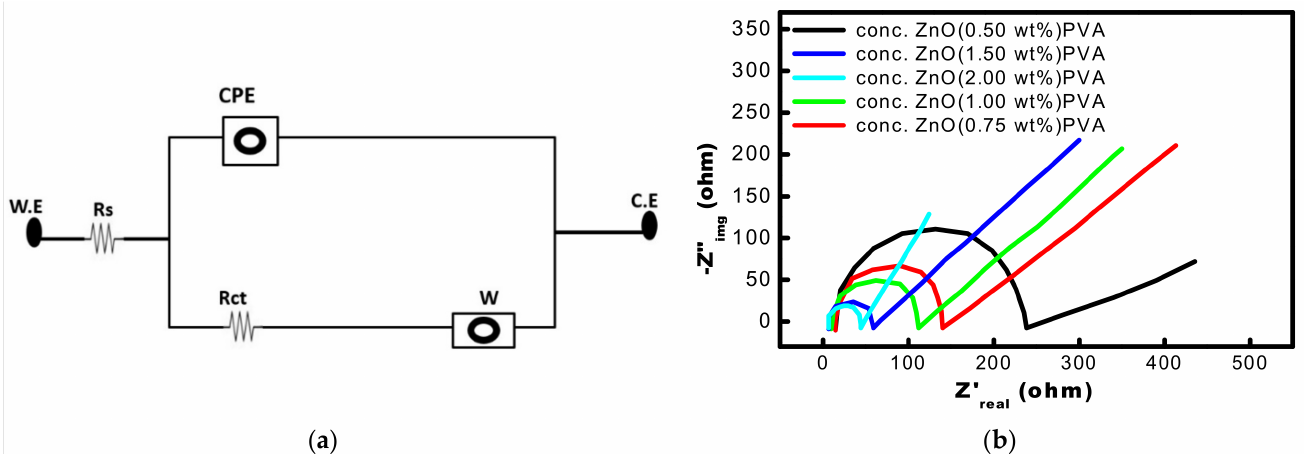
Figure 10. ( a ) The analogous circuit for a single-chambered MFC simulates different resistances. ( b ) Nyquist plot MFCs loaded with varying concentrations of Li-ZnO (0.50, 0.75, 1.00, 1.5, and 2.0 wt%) recorded at a frequency range of 1 MHz to 100 kHz (WE = working electrode, Rs = solution resistance, CPE = constant phase element, Rct = Charge transfer resistance, W = Warburg element, CE = counter electrode).